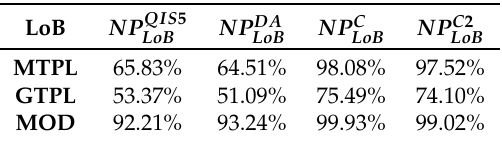
Table 3. NP LoB according to different methodologies.